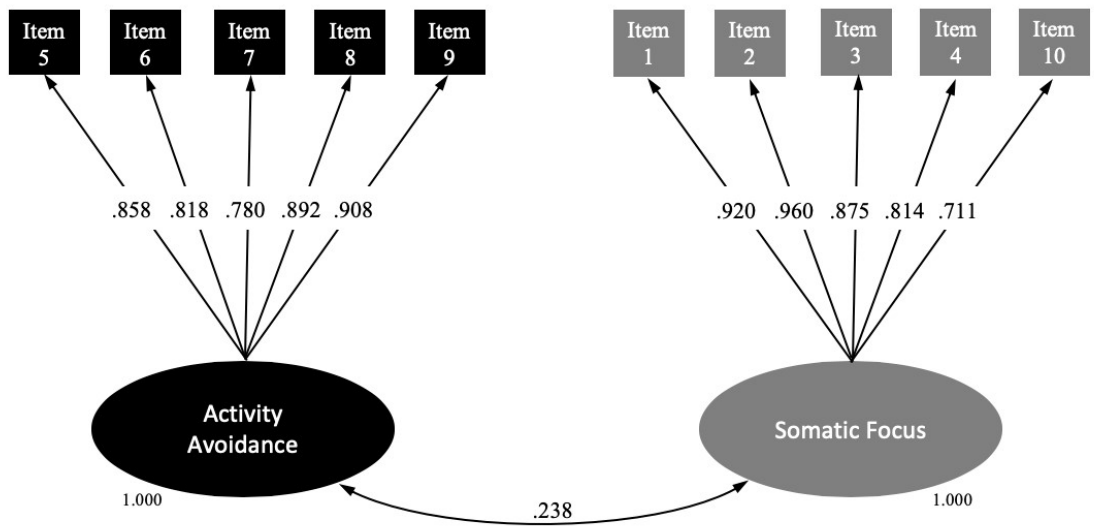
Figure 1. Structural equation modelling for the final Spanish version of the TSK-TMD.